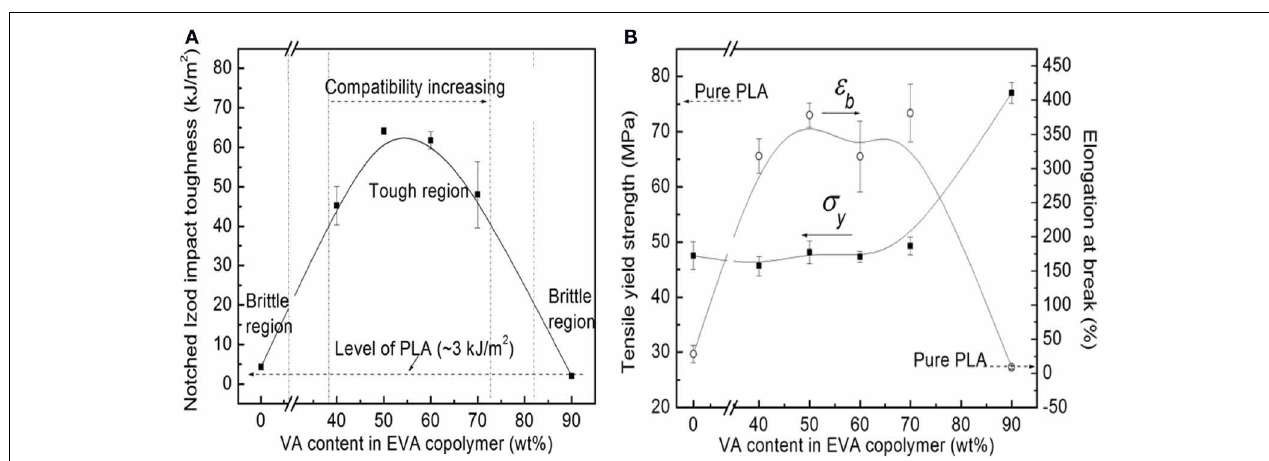
FIGURE 9 | (A) Impact toughness and (B) tensile properties of the PLA/EVA (80/20) blends as a function of VA content in the EVA copolymers [Reprinted from Ma et al. (2012) with permission from Elseiver].